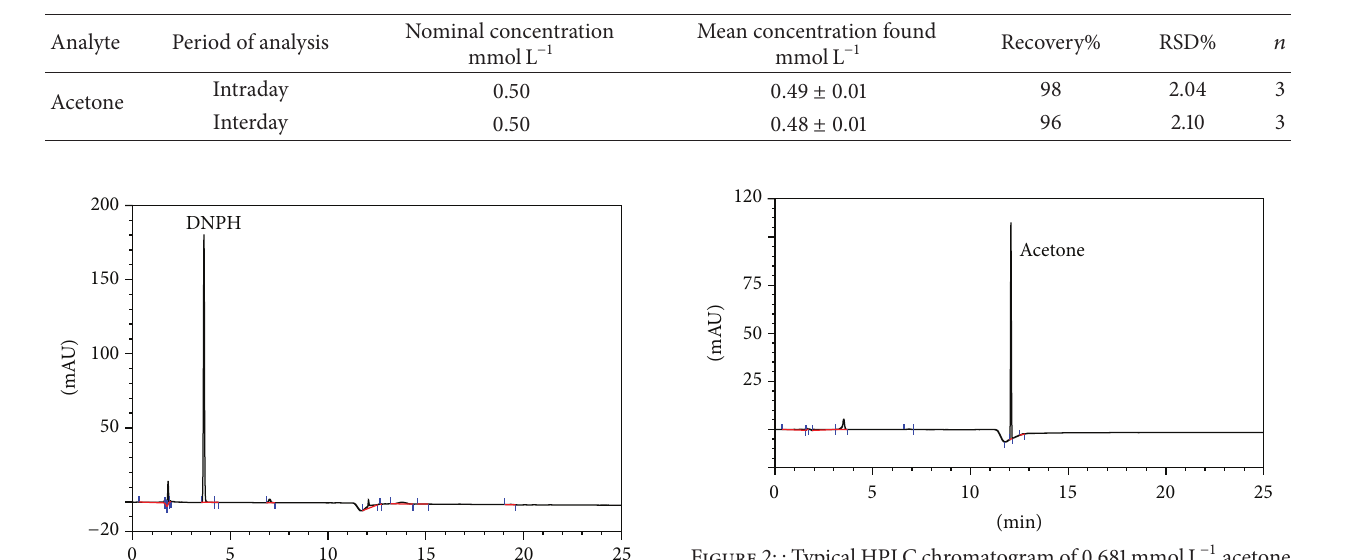
Table 2: Intraday and interday precision and accuracy of the applied method.